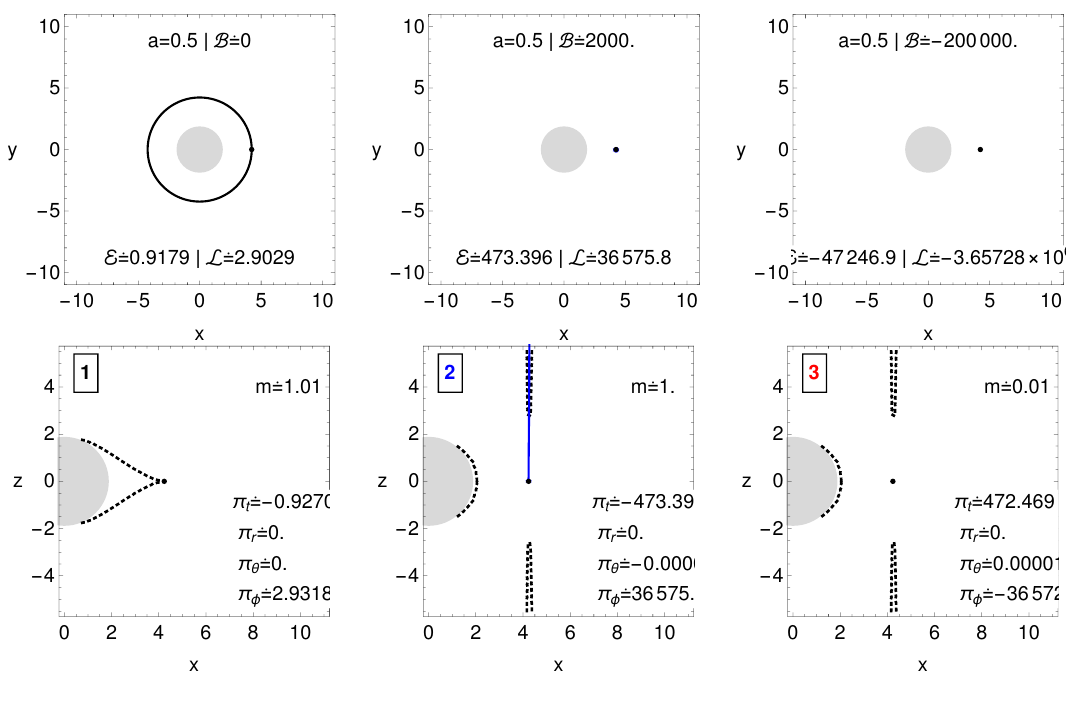
Figure 17. Similar situation as in Figure 16, but here the magnetic field parameter small and the second particle will not escape.